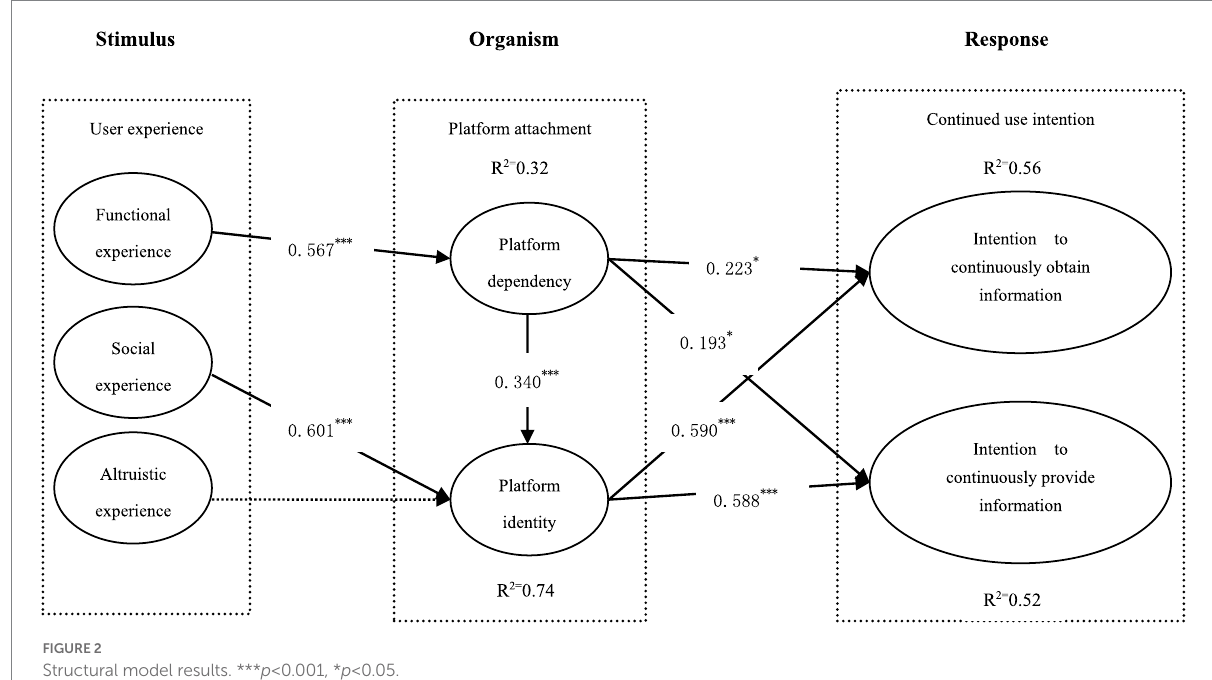
FIGURE 2 Structural model results. *** p < 0.001, * p <